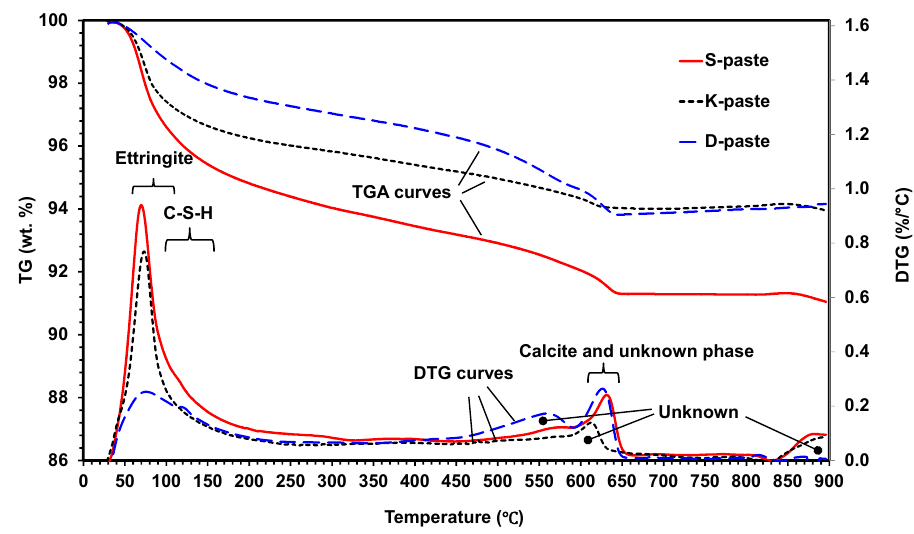
Figure 7. TGA and DTG results of 28-day hardened paste samples. Table 4. Temperature range of weight loss for reaction products from TGA analysis.